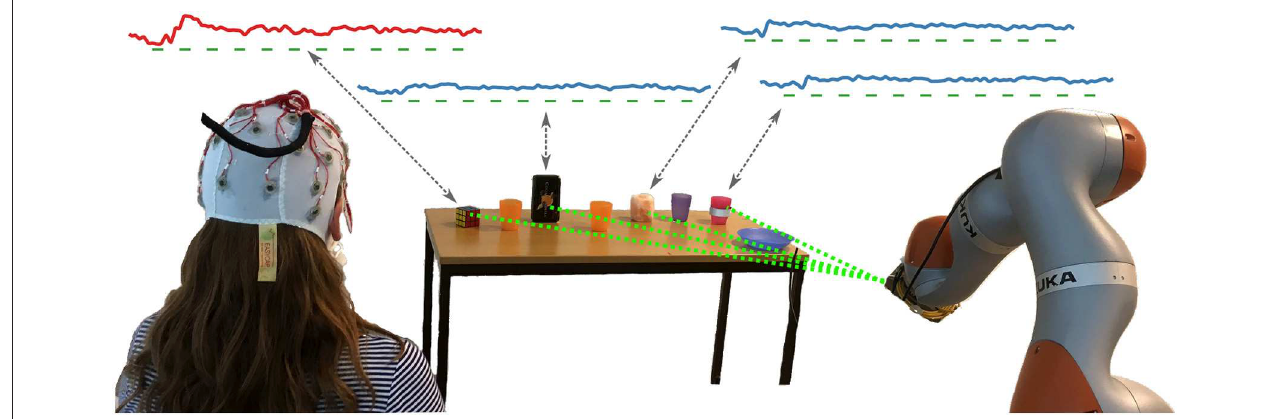
FIGURE 1 | Setup of our screen-free BCI: While the user attends to her goal object (the Rubik’s cube in this example), the robot sequentially highlights candidates in the environment using a laser pointer mounted adjacent to the end effector. As depicted by the grand averages in the top, the EEG responses to the highlighting stimuli (marked by green bars) differ between the target object of the user (the Rubik’s cube, red curve) and the other non-targets (blue curves). However, the optical properties cause dissimilar responses across objects for both classes. Our approach is able to robustly handle these differences in brain responses when predicting the user goal from the EEG response to each